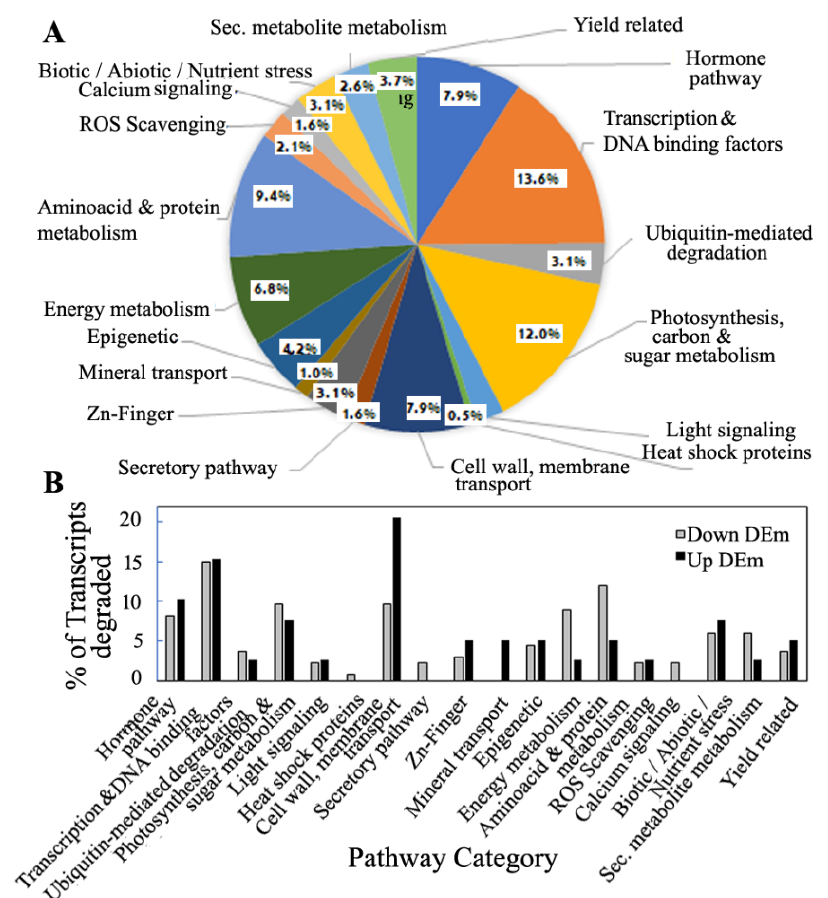
Figure 6. Pathway analysis of the degradome transcripts. Target transcript function was obtained using UniProt database and the RAP-DB and GO annotations. ( A ) Pathway categorization is presented in the form of percentage of the total number transcripts. The total number of transcripts represents transcripts cleaved after removal of hypothetical, unpredicted, and unknown samples, as well as samples with significant log 2 FC and p -values ( B ) Pathway categorization of percentage of transcripts based on up- or down-DEms.